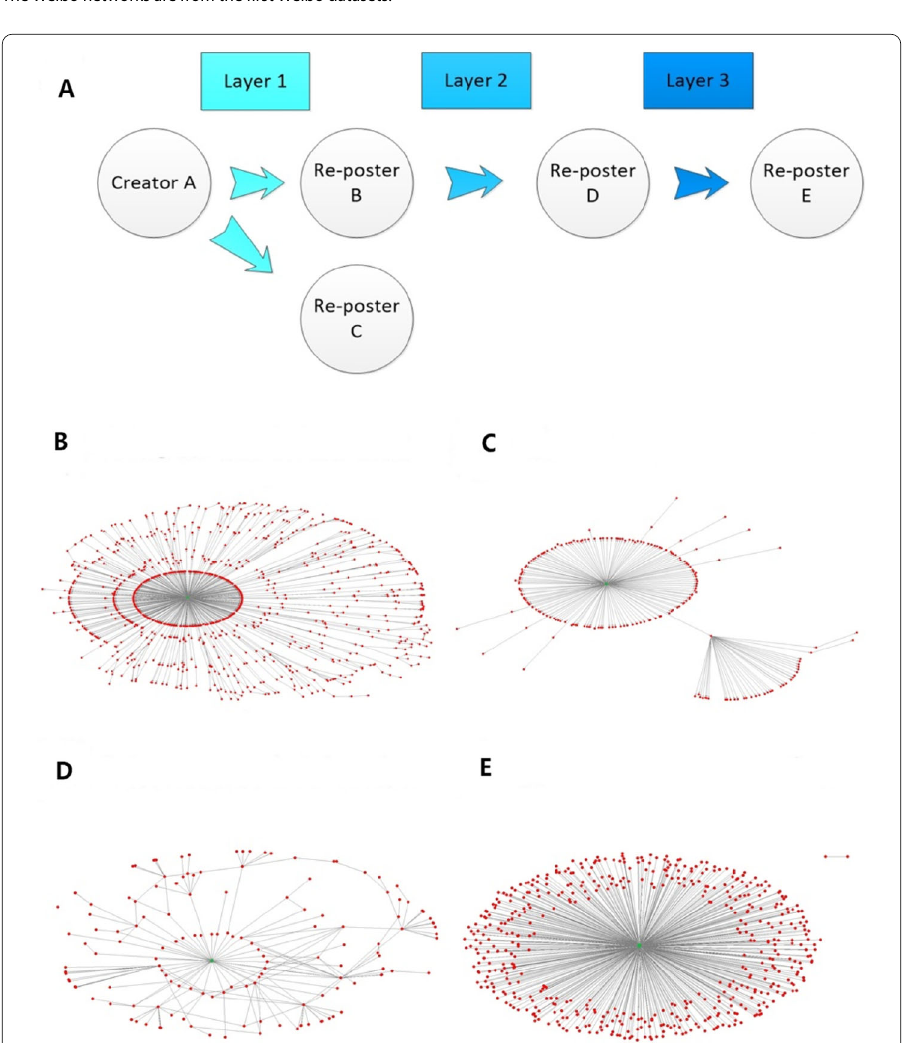
Figure 1 Typical examples of fake and real news networks. ( A ) Schematic diagram of the propagation of a post and its re-posting. The nodes represent the users and the edges are the re-postings. The directionality determines which user is the re-poster among the two users: the origin is the former re-poster and the target is the later re-poster. A layer consists of re-postings whose re-posters have the same distance from the creator. We color the edges according to their layer from light to dark blue. ( B ) A real typical Weibo network of fake news with 1123 nodes. The edge’s arrow stands for its direction. This fake news is about health problems due to a milk tea shop. ( C ) A typical Weibo real news network with 215 nodes. This is about a tip of preventing sunstroke. ( D ) A typical Twitter fake news network with 199 nodes. This tweet is about an electric store